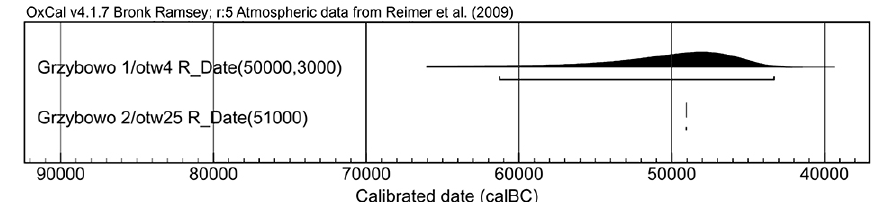
Fig. 6. calibration of radiocarbon data set in graphical